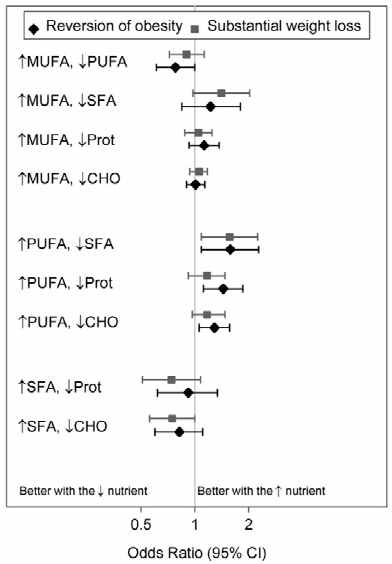
Figure 1. Estimated odds ratios (95% confidence interval) for reversion of obesity (grey squares) and substantial weight loss ( ≥ 10%, black diamonds) after isocaloric substitution of 5% energy from MUFA, PUFA, and SFA, proteins (Prot), and carbohydrates (CHO). Adjusted for the same confounders as the analyses in Table